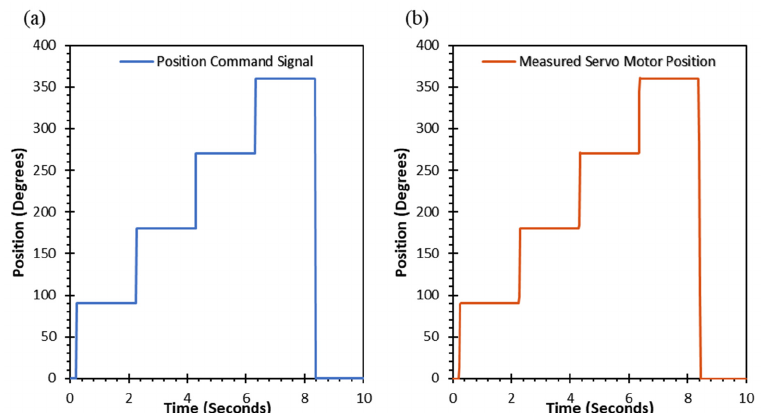
Figure 13. Graphs plotting ( a ) the required servo motor angular position against time and ( b ) the measured servo motor position against